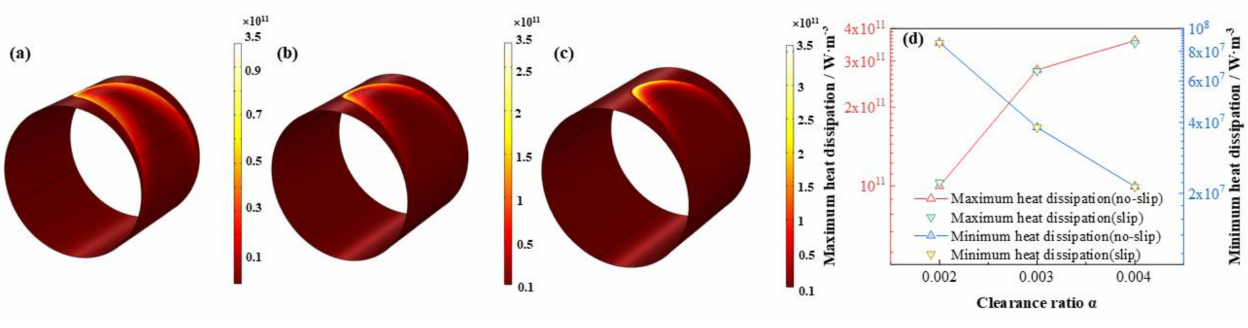
Figure 16. Comparison of the heat dissipation distribution under different length diameter ratios. ( a ) L / D = 0.5; ( b ) L / D = 0.83; ( c ) L / D = 1.0; ( d ) maximum/minimum heat